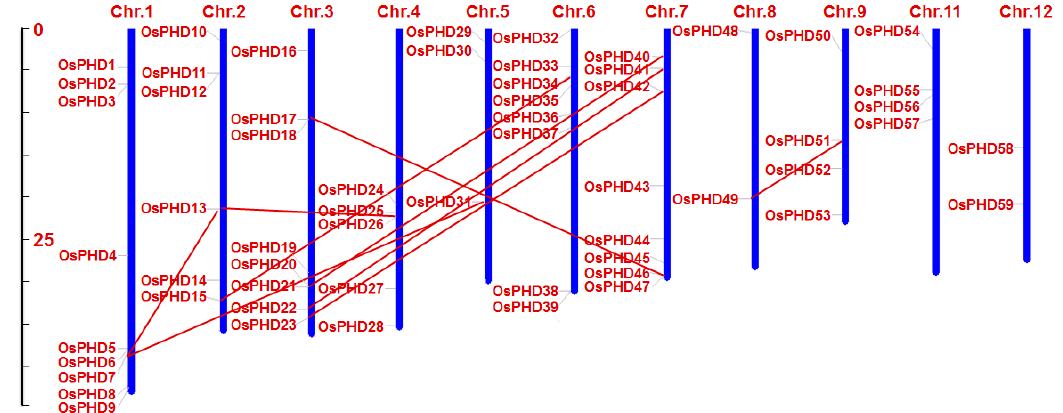
Figure 2. Chromosomal distribution of the rice PHD family genes. The blue bars represent the chromosomes and the chromosome numbers are shown at the top of the bars. The duplicated gene pairs are identified and connected by solid lines. The scale bar on the left represents the length of the chromosome.